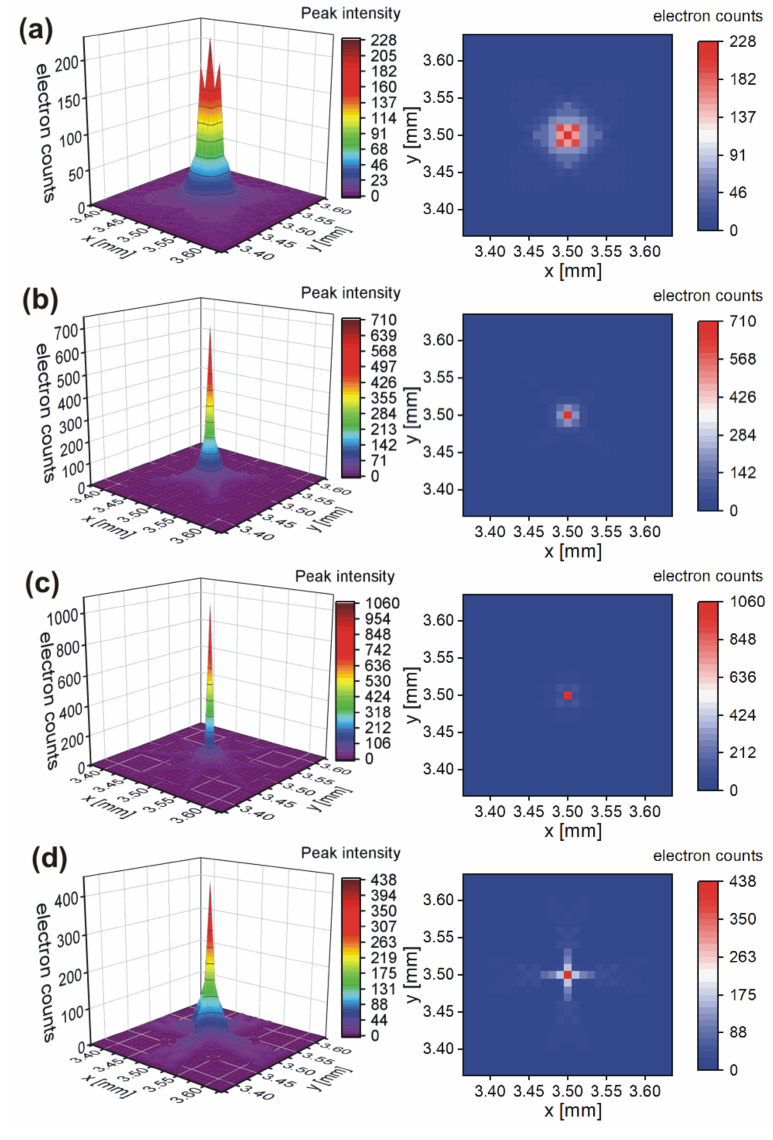
Figure 5. Three-dimensional plots and heat maps of the beam spot on the membrane for different focal voltages: ( a ) U F = − 1820 V; ( b ) U F = − 1840 V; ( c ) U F = − 1860 V; ( d ) U F = − 1880